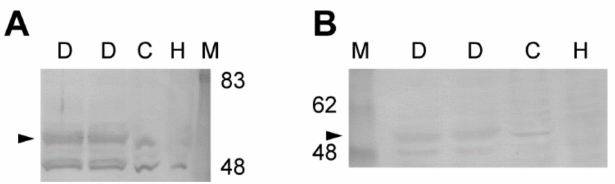
Figure 5. Immunoblot of A 2A ( A ) and A 2B ( B ) adenosine receptors from the rat pancreatic duct. Protein samples were resolved by SDS-PAGE. Arrowheads indicate adenosine receptor proteins detected by immunoblotting using anti-ADORA2A ( A , 1:200, sc-13937) or anti-ADORA2B ( B , 1:1000, AAR-003) antibody. Representative membranes from two independent experiments are shown. M, marker; D, duct; C, Capan-1; H,